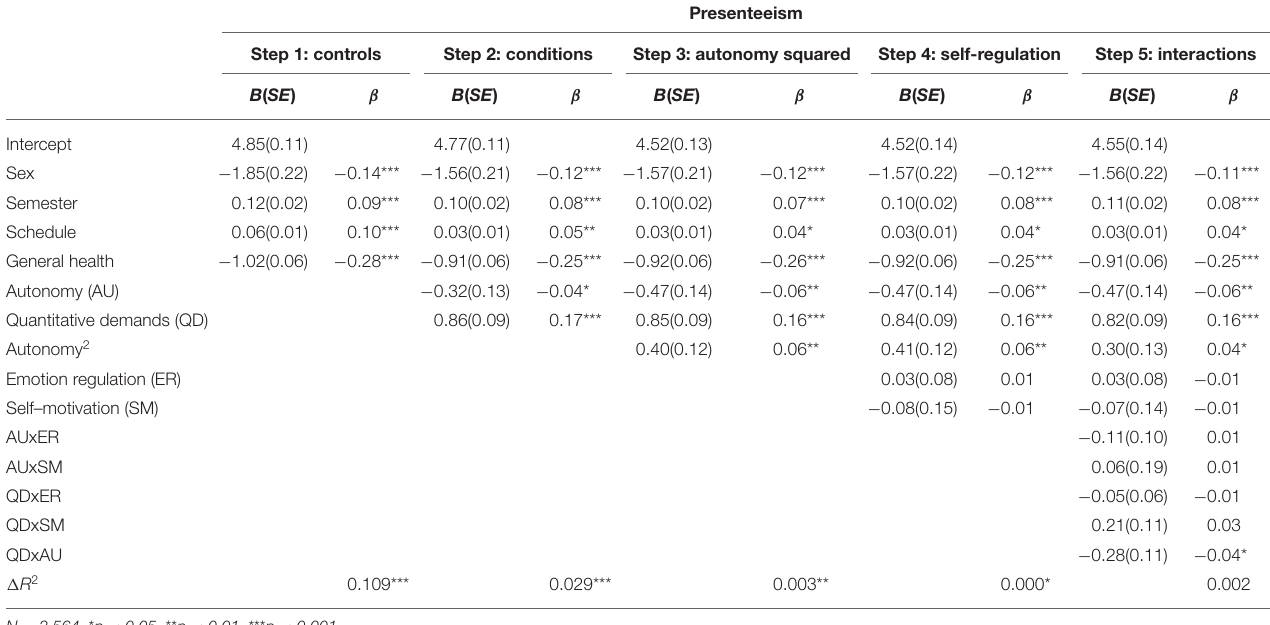
TABLE 3 | Stepwise regression analysis for the dependent variable presenteeism.